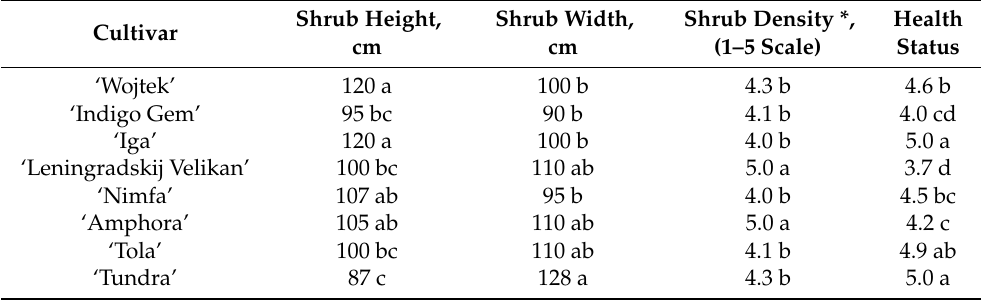
Table 2. Shrub parameters and health status of blue honeysuckle cultivars, 2020.